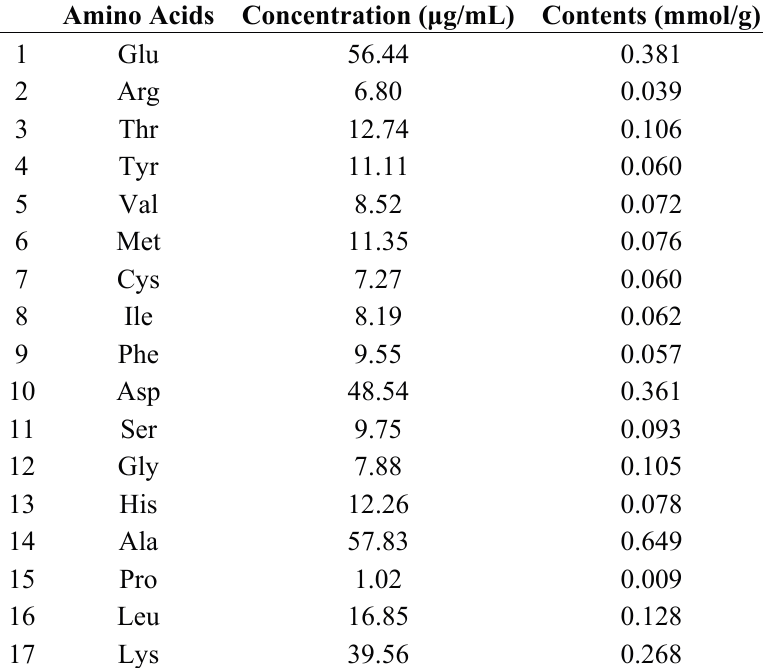
Table 1. The composition and contents of amino